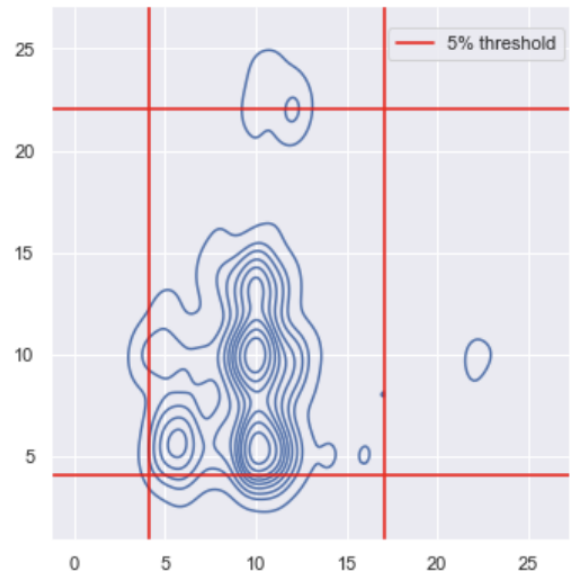
Figure 13. Distribution of the training bivariate Fourier values of both the respiration and the ocular movement and the threshold of 5% (red lines) of the values to be defined as